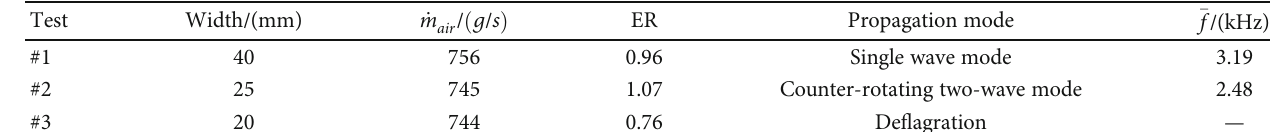
Table 1: The typical experimental tests.